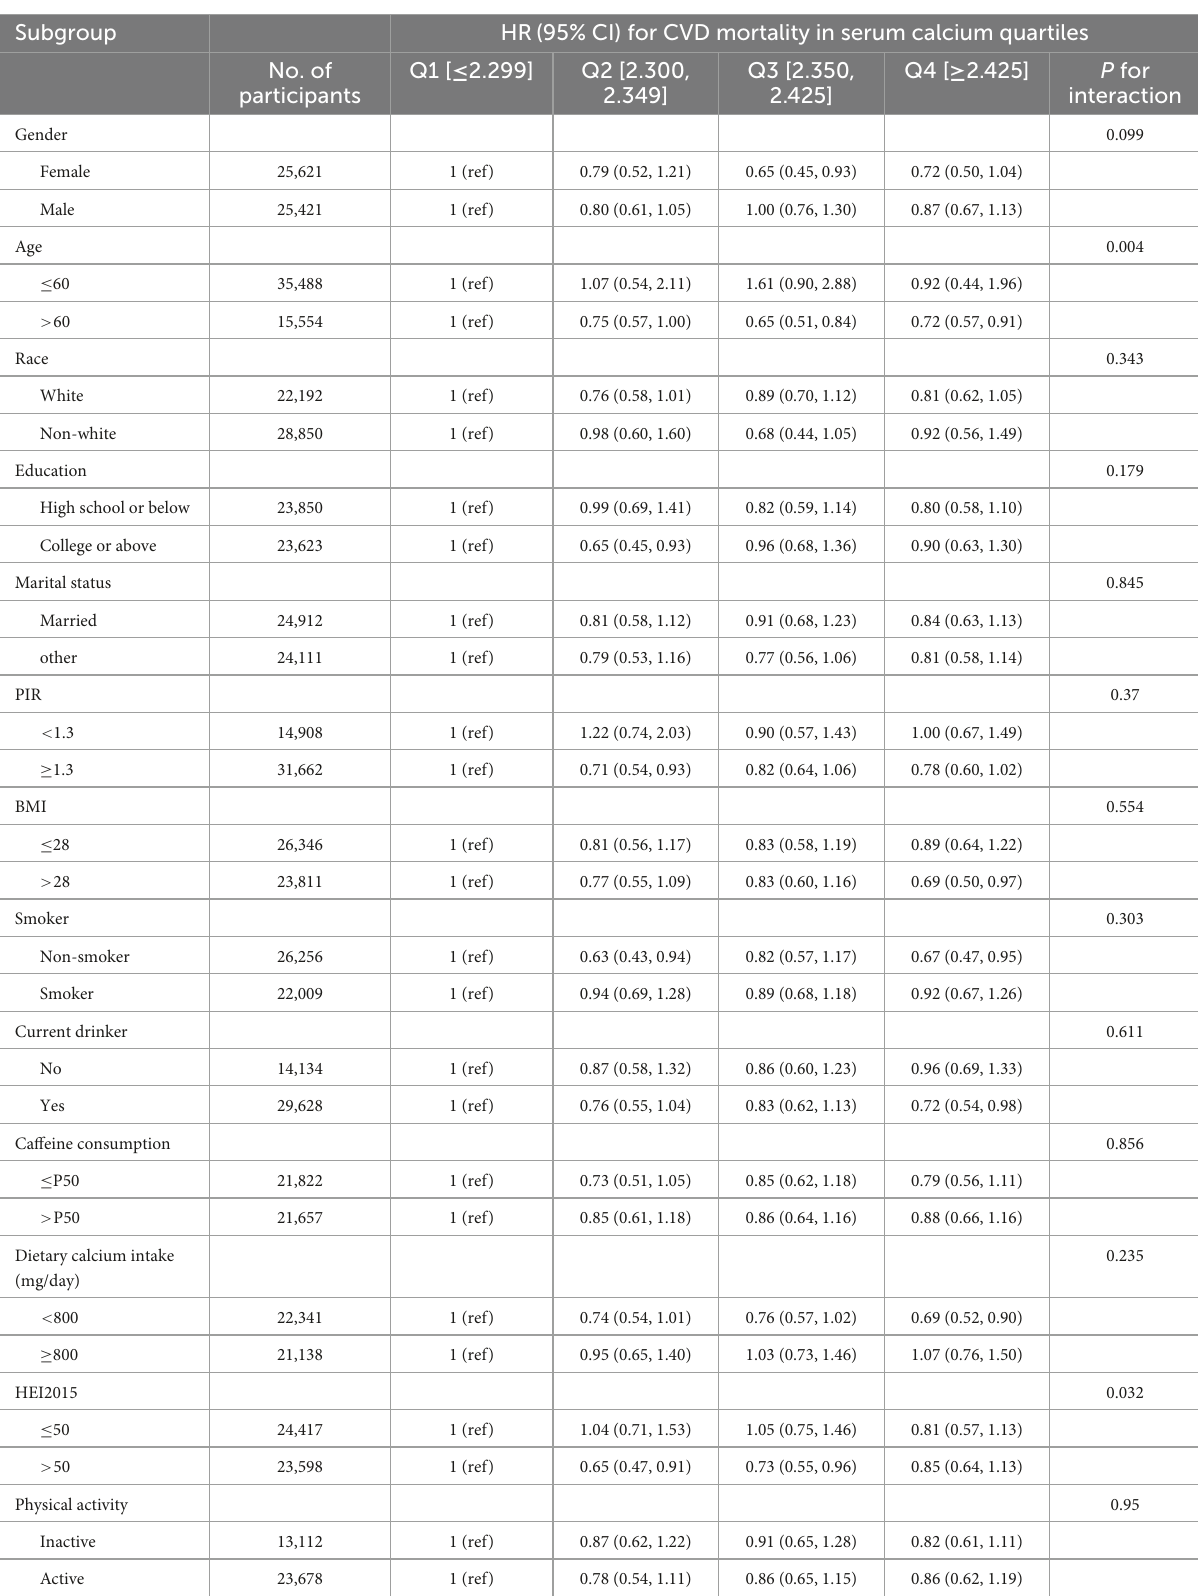
TABLE 4 Subgroup analyses of the associations of serum calcium quartiles with CVD mortality.